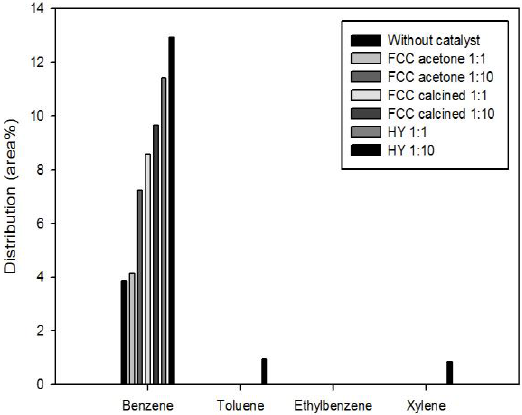
Figure 8. Comparison of the benzene, toluene, ethylbenzene, and xylene (BTEX) fractions obtained from non-catalytic and catalytic pyrolyses of wild reed.